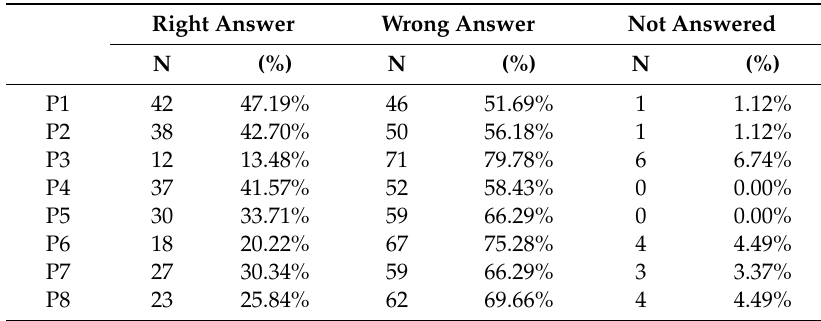
Table 3. Results of the student in the level test.